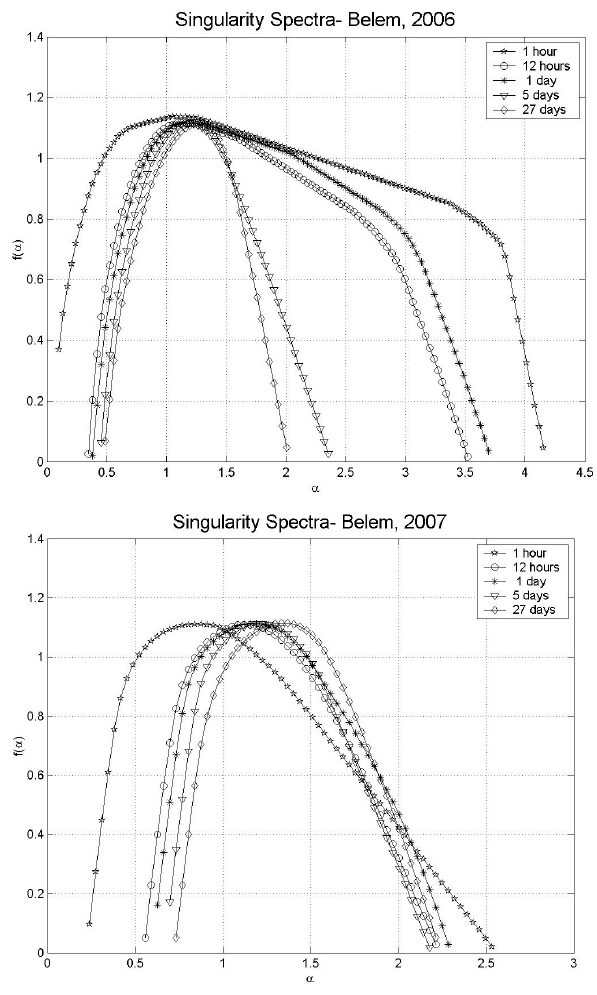
Fig. 4. Singularity spectrum for characteristic time scales shown in Figure 4: Singularity spectrum for characteristic time scales shown in legend for 448 legend for Bel´em, 2006 and 2007. Belém, 2006 and 2007 years. 449